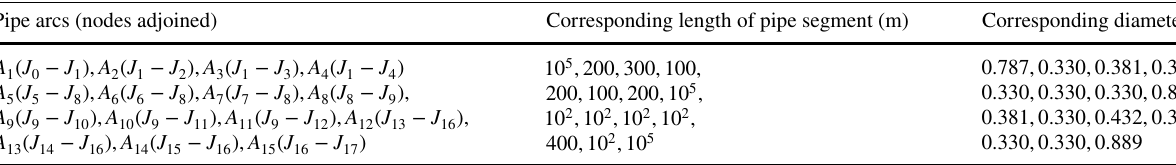
Table 1 Dimensions of gas pipeline network Pipe arcs (nodes adjoined) Corresponding length of pipe segment (m)